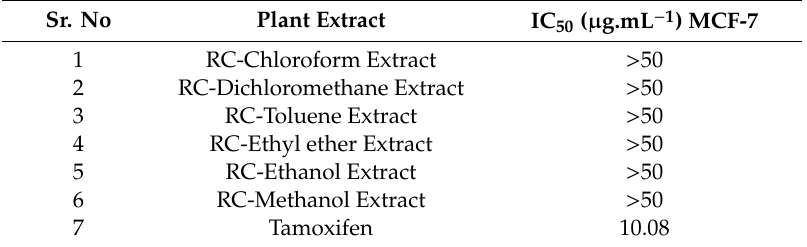
Table 4. Cytotoxic properties of di ff erent extracts of RC in MCF-7 cell line. Sr.